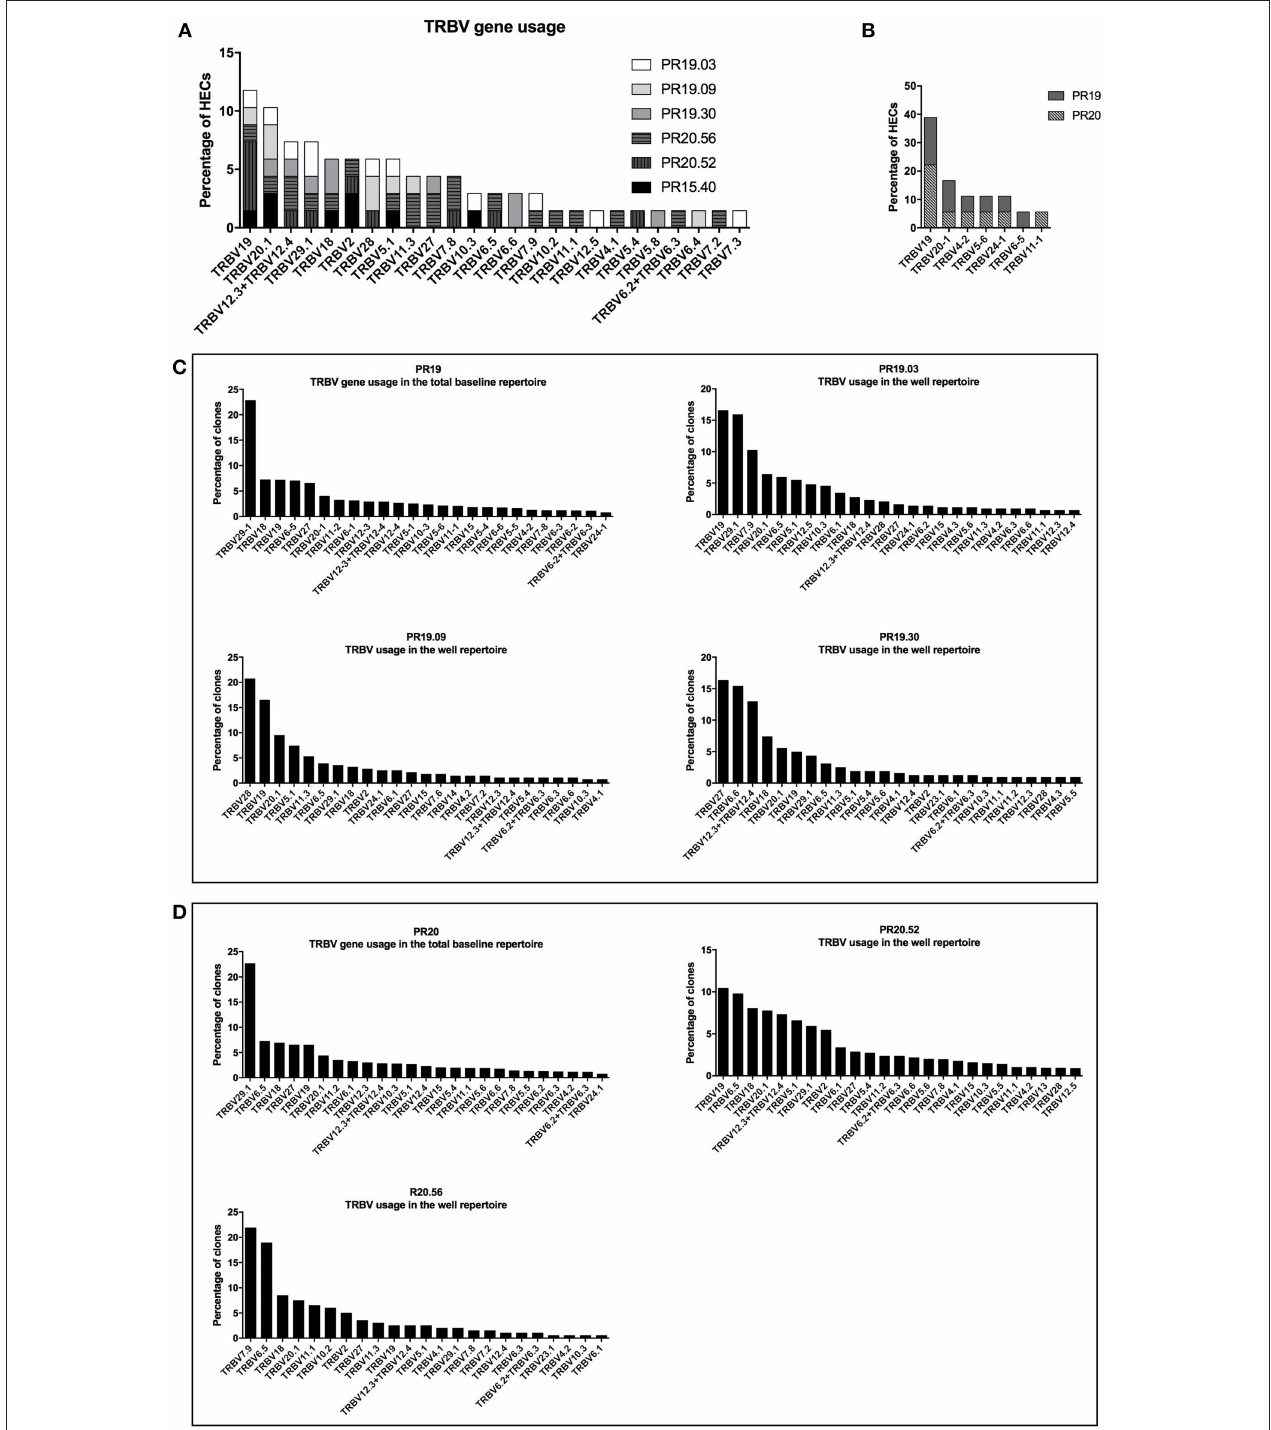
FIGURE 6 | TCR β repertoire analysis of nickel-recognizing naïve CD4 + T-cell lines. TCR β variable gene usage of the highly expanded clones (HECs) detected in the six nickel-specific T-cell lines analyzed (A) and in the sorted naïve CD4 + T-cells from donors PR19 and PR20 (B) . TCR β variable gene usage in the total repertoire pre- and post-stimulation in donors PR19 (C) and PR20 (D) . The percentage of clones (or HECs) carrying a particular TCR β variable gene (TRBV) is depicted on the y-axis. All the genes names follow the IMGT nomenclature.